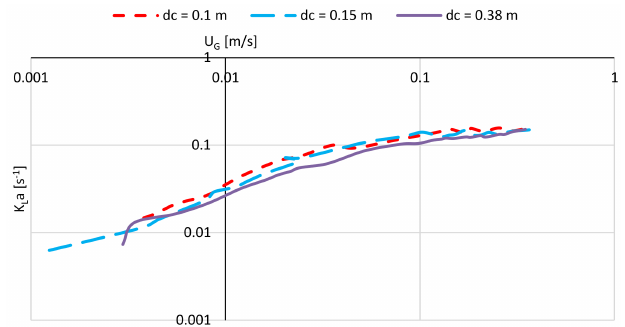
Figure 32. Influence of the bubble column diameter on k L a —data from Vandu and Krishna [304].